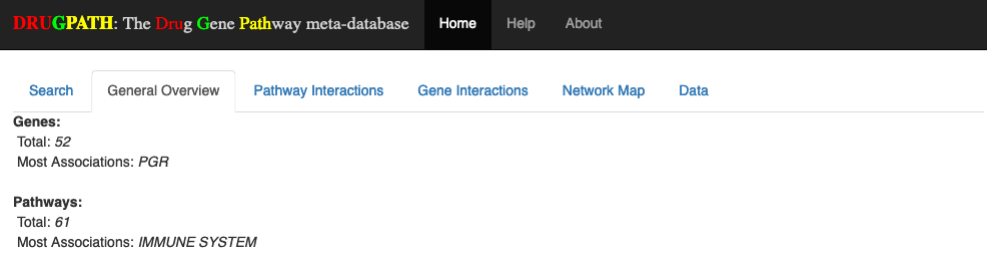
Figure 7. General overview of the interacting genes and pathways between enbrel and